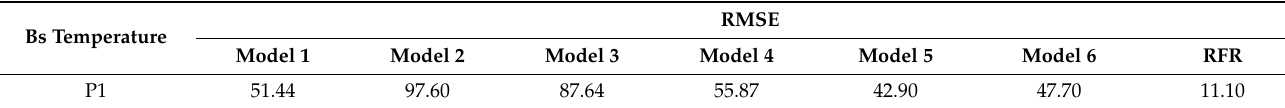
Table 6. Weight percentage of composition of Nb-added steel.